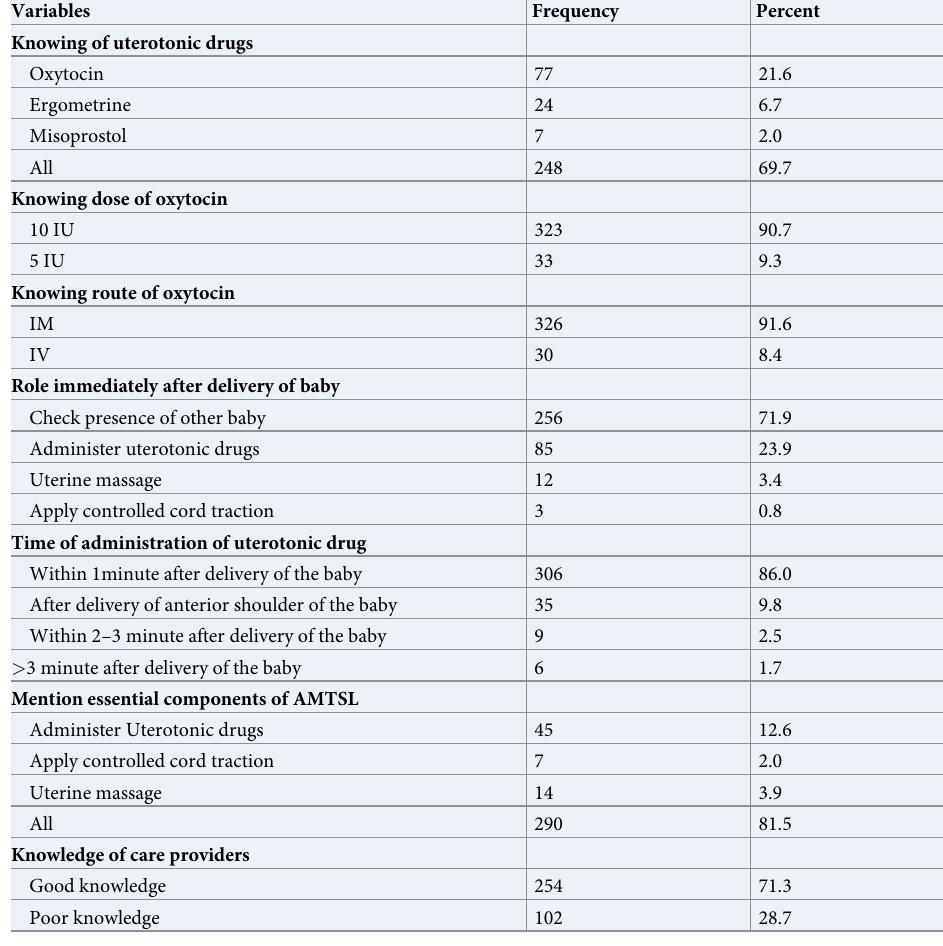
Table 3. Knowledge of obstetric care providers.